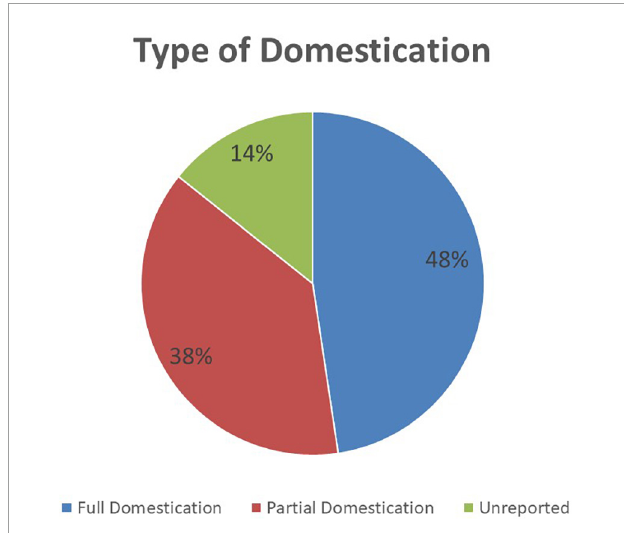
FIGURE3 The type of AU Model Law domestication performed or being performed by 21 African national medicines regulatory authorities (NRAs) ( N =